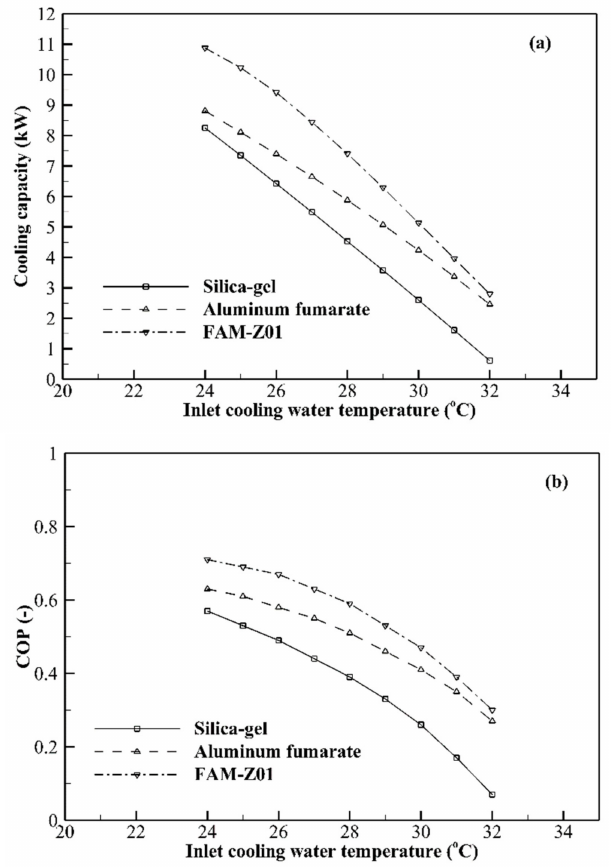
Figure 7. Influence of inlet cooling water temperature on: ( a ) cooling capacity and ( b )